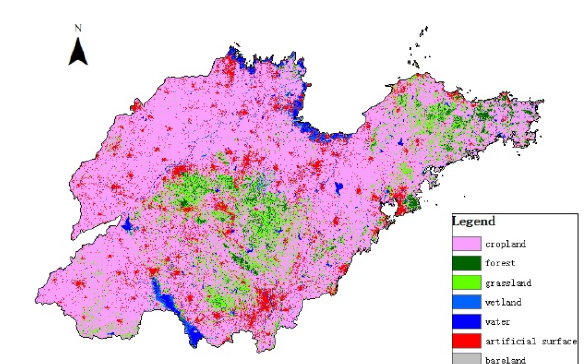
Figure 2. Our classified product with highest test accuracy in Shandong in 2010